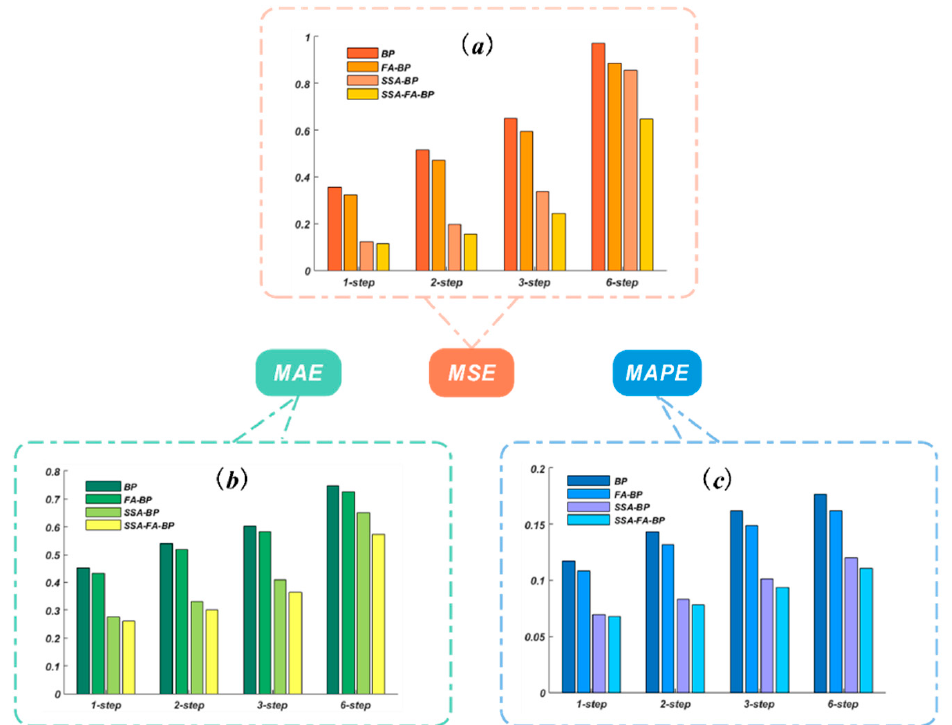
Figure 6. The quarterly forecasting results of the wind series of Unit 12 with one ‐ step (10 min), ( a ) refers to the result of MSE; ( b ) refers to the result of MAE; ( c ) refers to the result of MAPE).